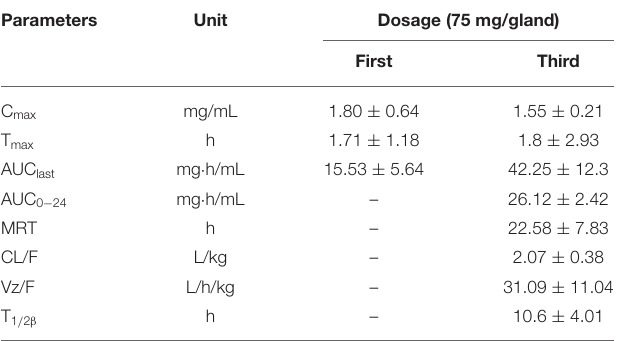
TABLE 1 | Pharmacokinetic parameters of cefquinome in milk following the administration of three consecutive IMM of 75mg cefquinome in each breast of 3 cows (Mean ± SD, n =